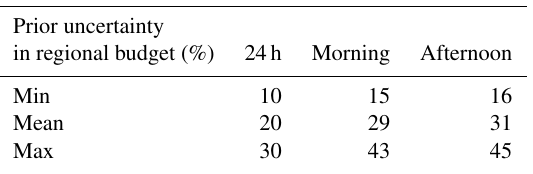
Table 4. Range of standard deviations of the prior uncertainty in regional 24h, morning, and afternoon budgets of FF emissions in the main area of interest. These budgets include the urban areas and point sources within the